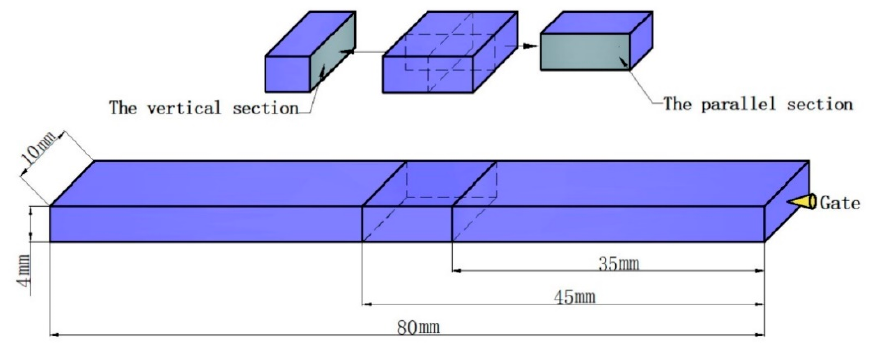
Figure 2. Preparation of the vertical and parallel sections from the flexural sample.